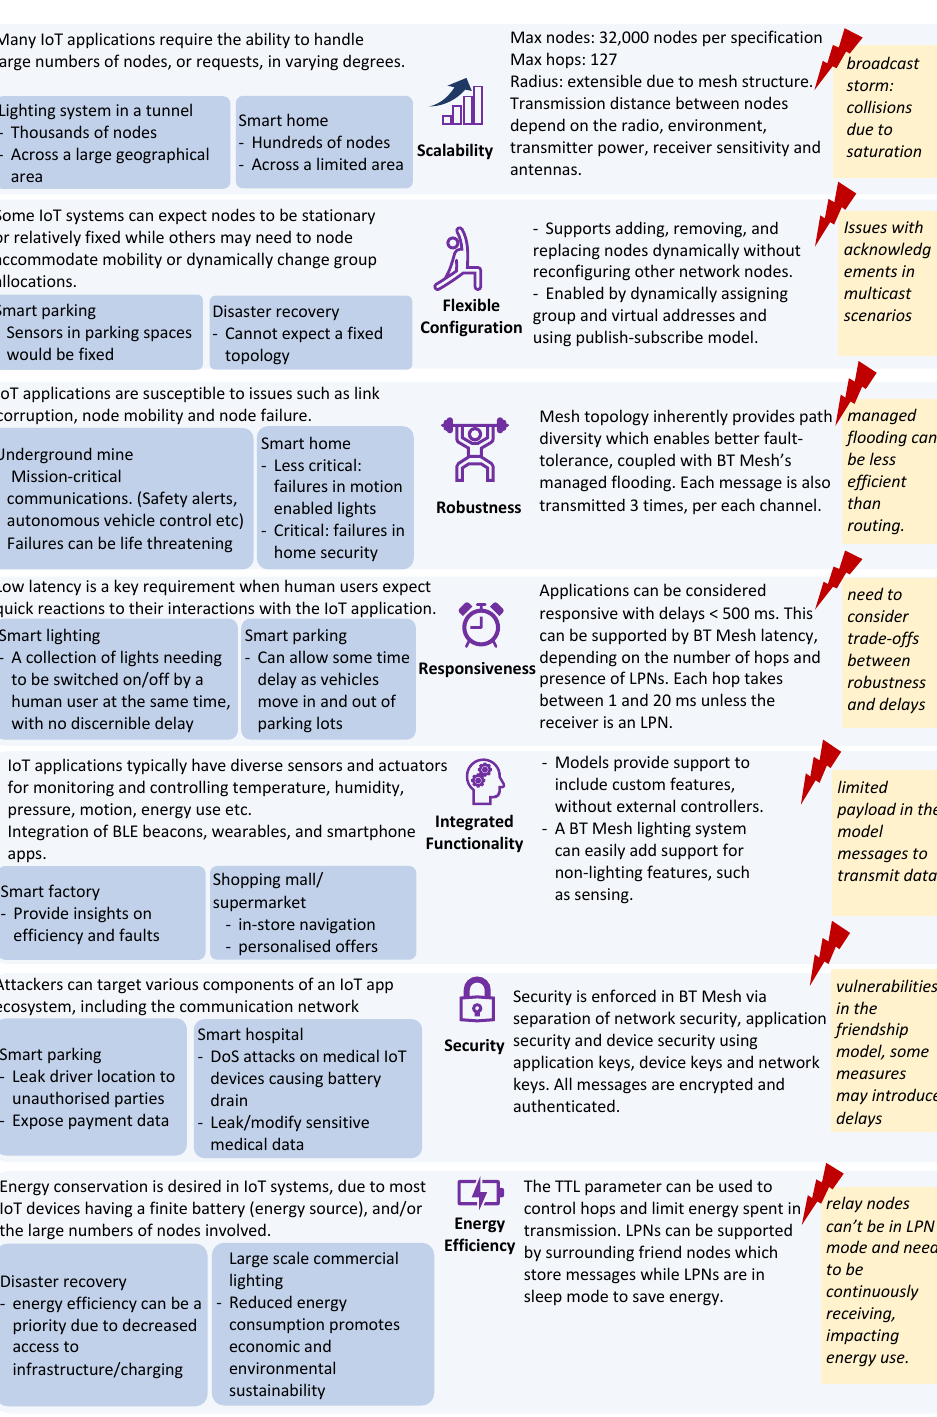
Figure 6. IoT application requirements mapped with BT Mesh features and